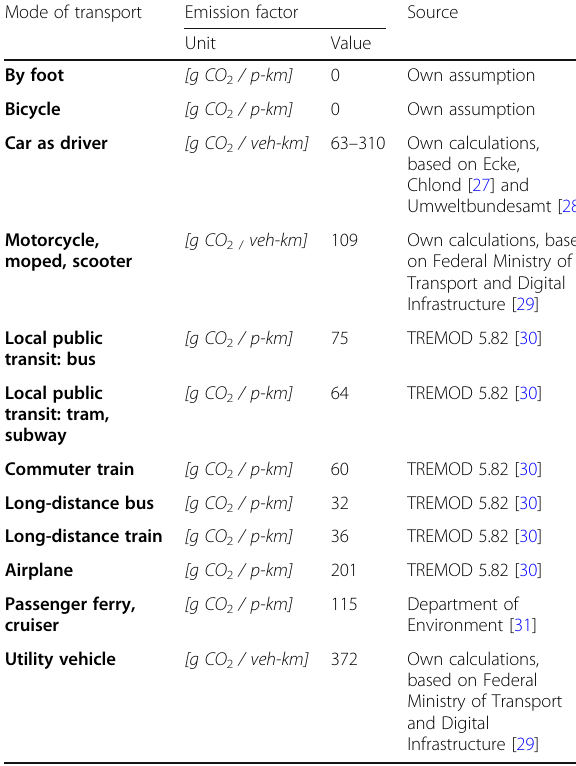
Table 1 Emission Factors Considered in the